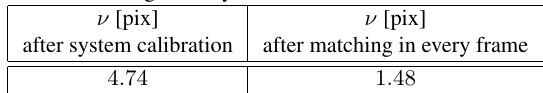
Table 1: Quality measure ν calculated after system calibration and after matching in every frame ν [pix] ν [pix] after system calibration after matching in every frame 4 . 74 1 . 48